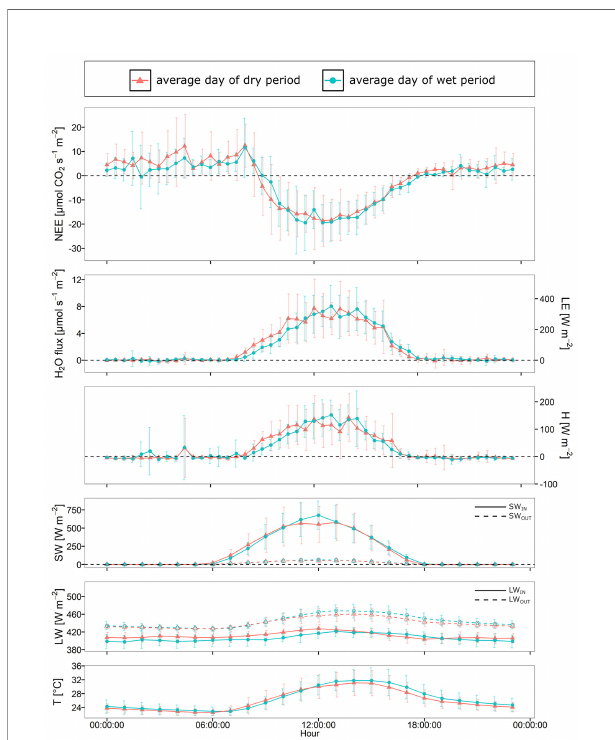
FIGURE 4 | Sample data of the CongoFlux eddy covariance fl ux tower, Yangambi (DR Congo). Net ecosystem exchange (NEE), water fl ux (H 2 0 fl ux), latent (LE) and sensible (H) heat fl ux, short wave incoming radiation (SW IN ) and short wave outgoing radiation (SW OUT ), long wave incoming radiation (LW IN ) and long wave outgoing radiation (LW OUT ), and air temperature (T) for an average day within a dry period (red, 01/01/2021 – 30/01/2021, P tot = 88 mm) and wet period (blue, 23/10/2020 – 21/11/2020, P tot = 283 mm). The above fl ux-data (NEE, H 2 0, LE and H fl uxes) were processed by using LICOR EddyPro 7 software (Version 7.0.6). Because of the nature and purpose of data presented, no post-processing (e.g. gap- fi lling, storage correction) has been applied. The fl uxes) were all quality checked using the steady- fl ux data (NEE, H 2 0, LE and H state test (58). Using this method fl uxes are divided in best quality (0), suitable for analysis (1) and bad fl uxes (2). Only fl uxes fl agged as 0 and 1 were